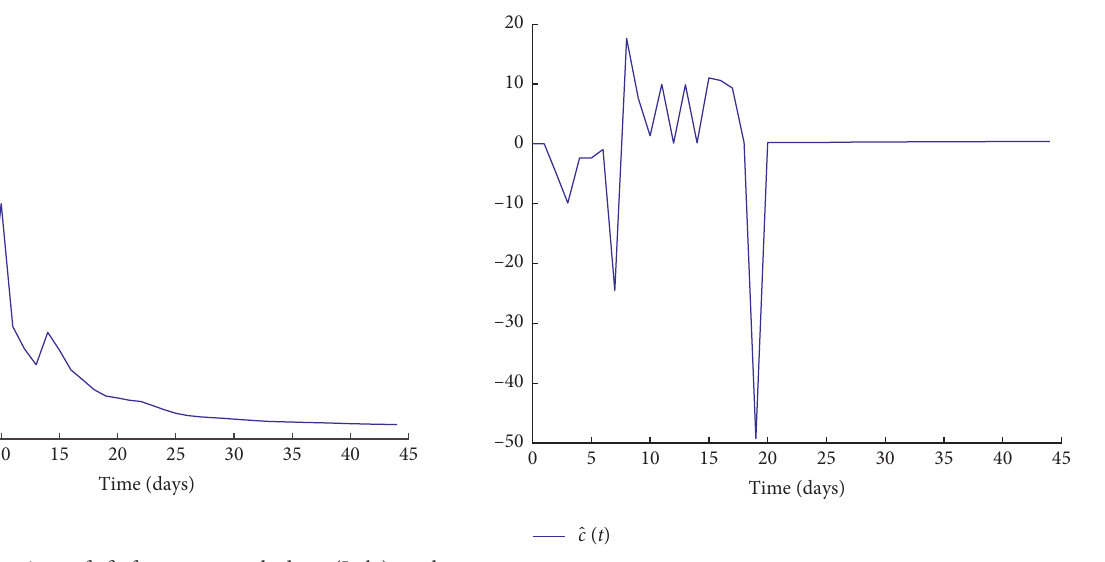
Figure 19: Estimation of the carrying capacity from reported filtered data (Italy) and lsqcurvefit Matlab function.